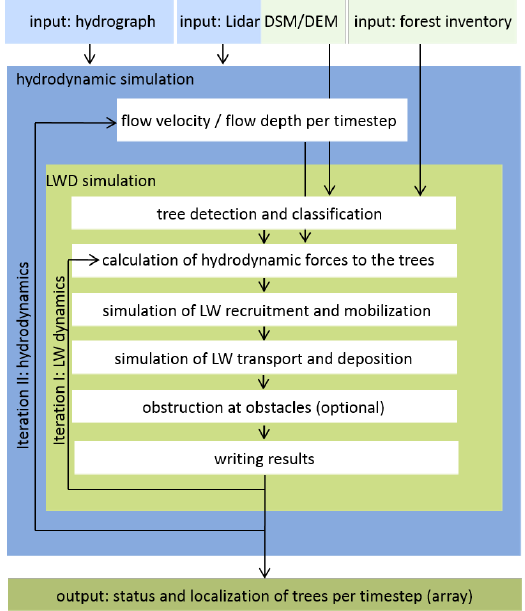
Figure 1. General framework of large wood dynamics (LWD) simulation in LWDsimR. DSM, digital surface model; DEM, digital elevation model; LW, large wood.